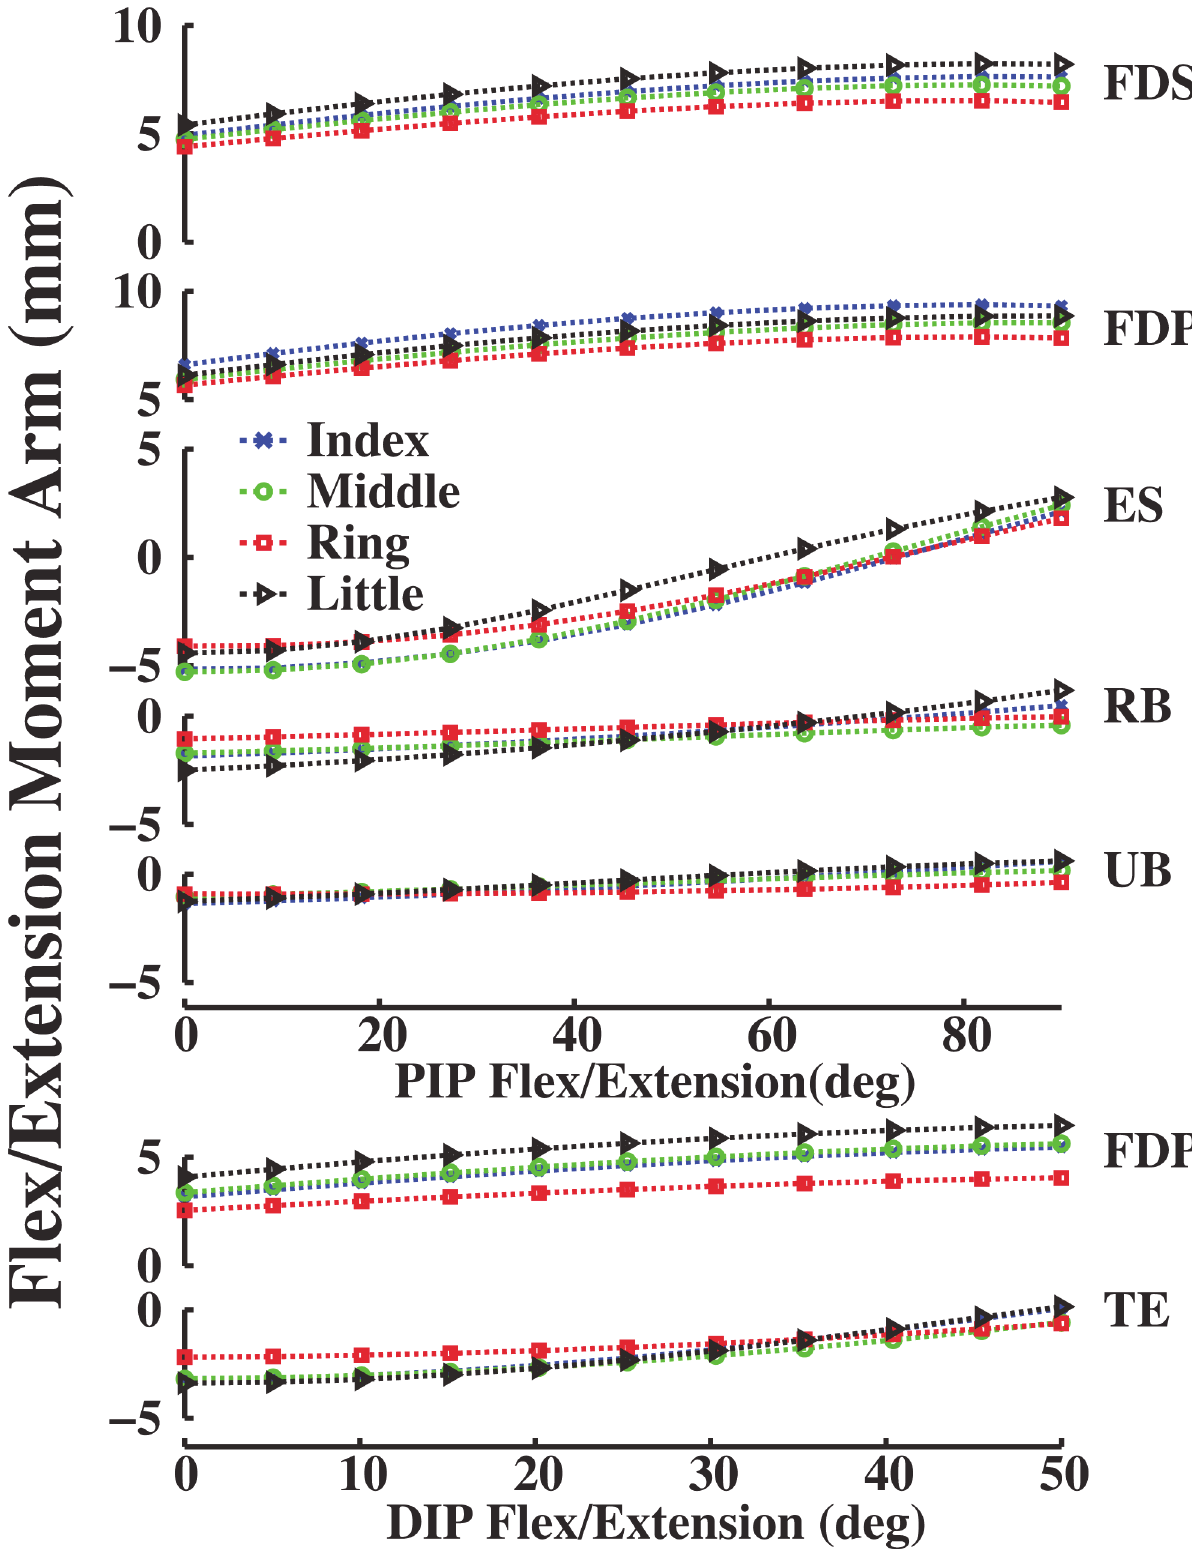
Fig 4. Flex/extension moment arms (mm) as a function of flexion (+)/ extension (-) at the PIP and DIP joints of the all fingers. Symbols are the same as in Fig 2. doi:10.1371/journal.pone.0121712.g004 PLOS ONE | DOI:10.1371/journal.pone.0121712 April 8,